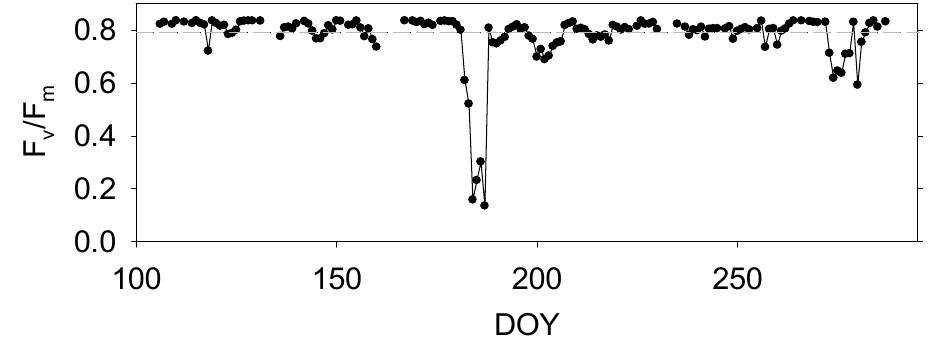
Figure 7. Seasonal variation of daily maximal quantum yield of PSII photochemistry (F v /F m ) in Salix psammophila during 2012 growing season.